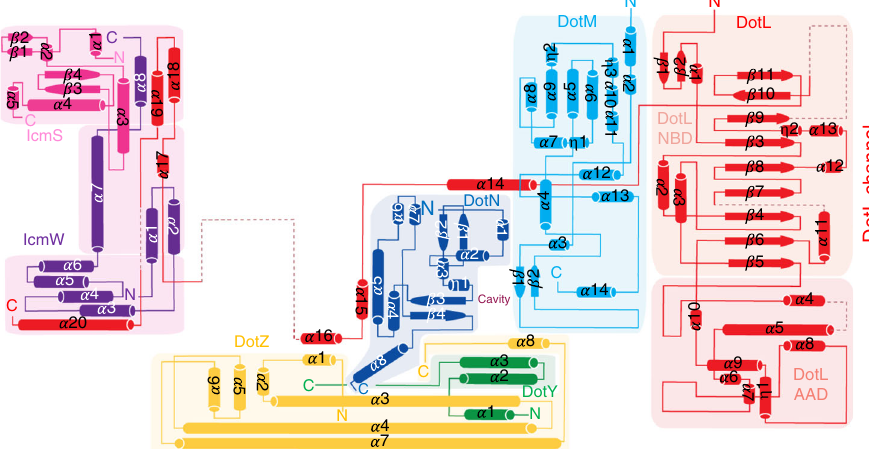
Fig. 2 Topology diagram of the T4CC hetero-pentameric core structure. Color-coding for DotL, DotM, DotN, DotZ, and DotY is as in Fig. 1e. IcmS and IcmW are in magenta and purple, respectively. Strands and helices are represented as arrows and cylinders, respectively. Secondary structures are labelled, as well as N- and C-termini. For DotL, NBD and AAD stands for nucleotide-binding and all alpha-helical domains, respectively. The location of the DotL channel in the hexamer and the cavity in which the DotM-bound Glu-rich SP inserts are